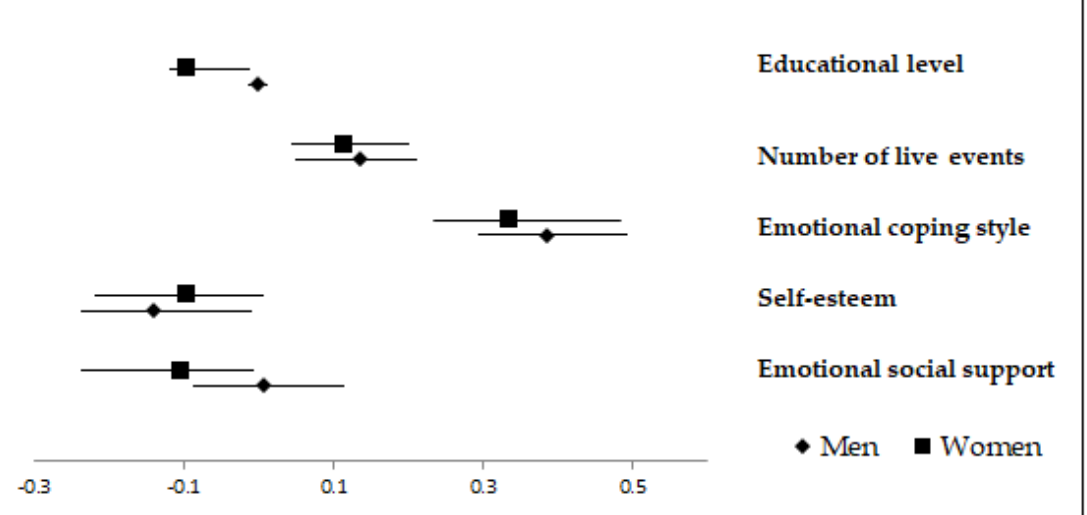
Figure 1. Beta values (95% CI) in the final model for men and women in the regression predicting psychological distress.